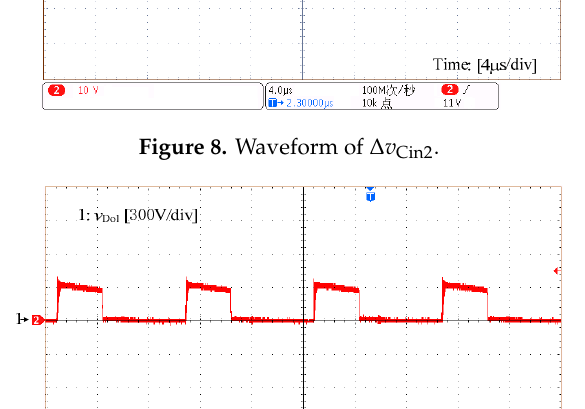
Figure 10. Waveform of v Q2P and i Q2P .